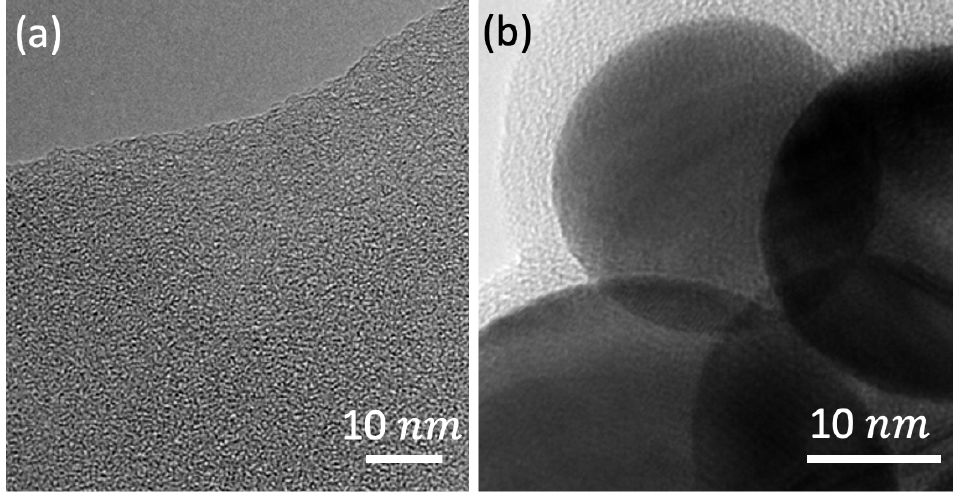
Figure A1. The TEM images of constituents used for the field-induced sponge fabrication:( a ) disor- dered shungite particles; ( b ) gold